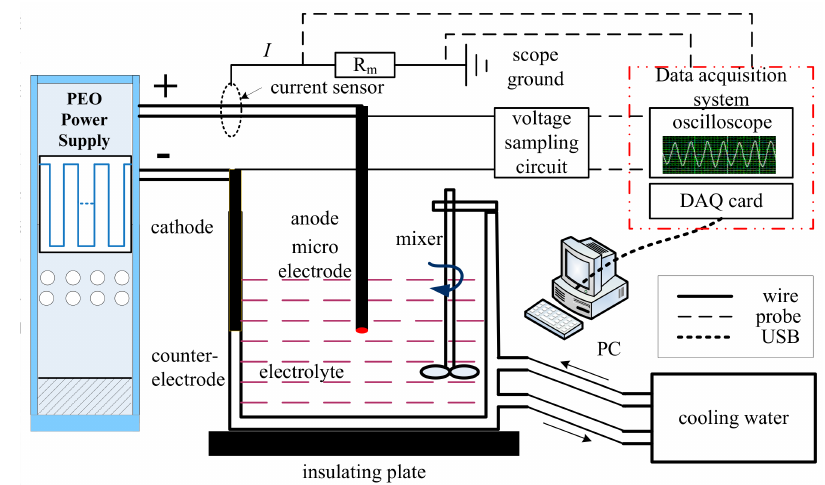
Figure 1. Schematic of the experimental platform for plasma electrolytic oxidation